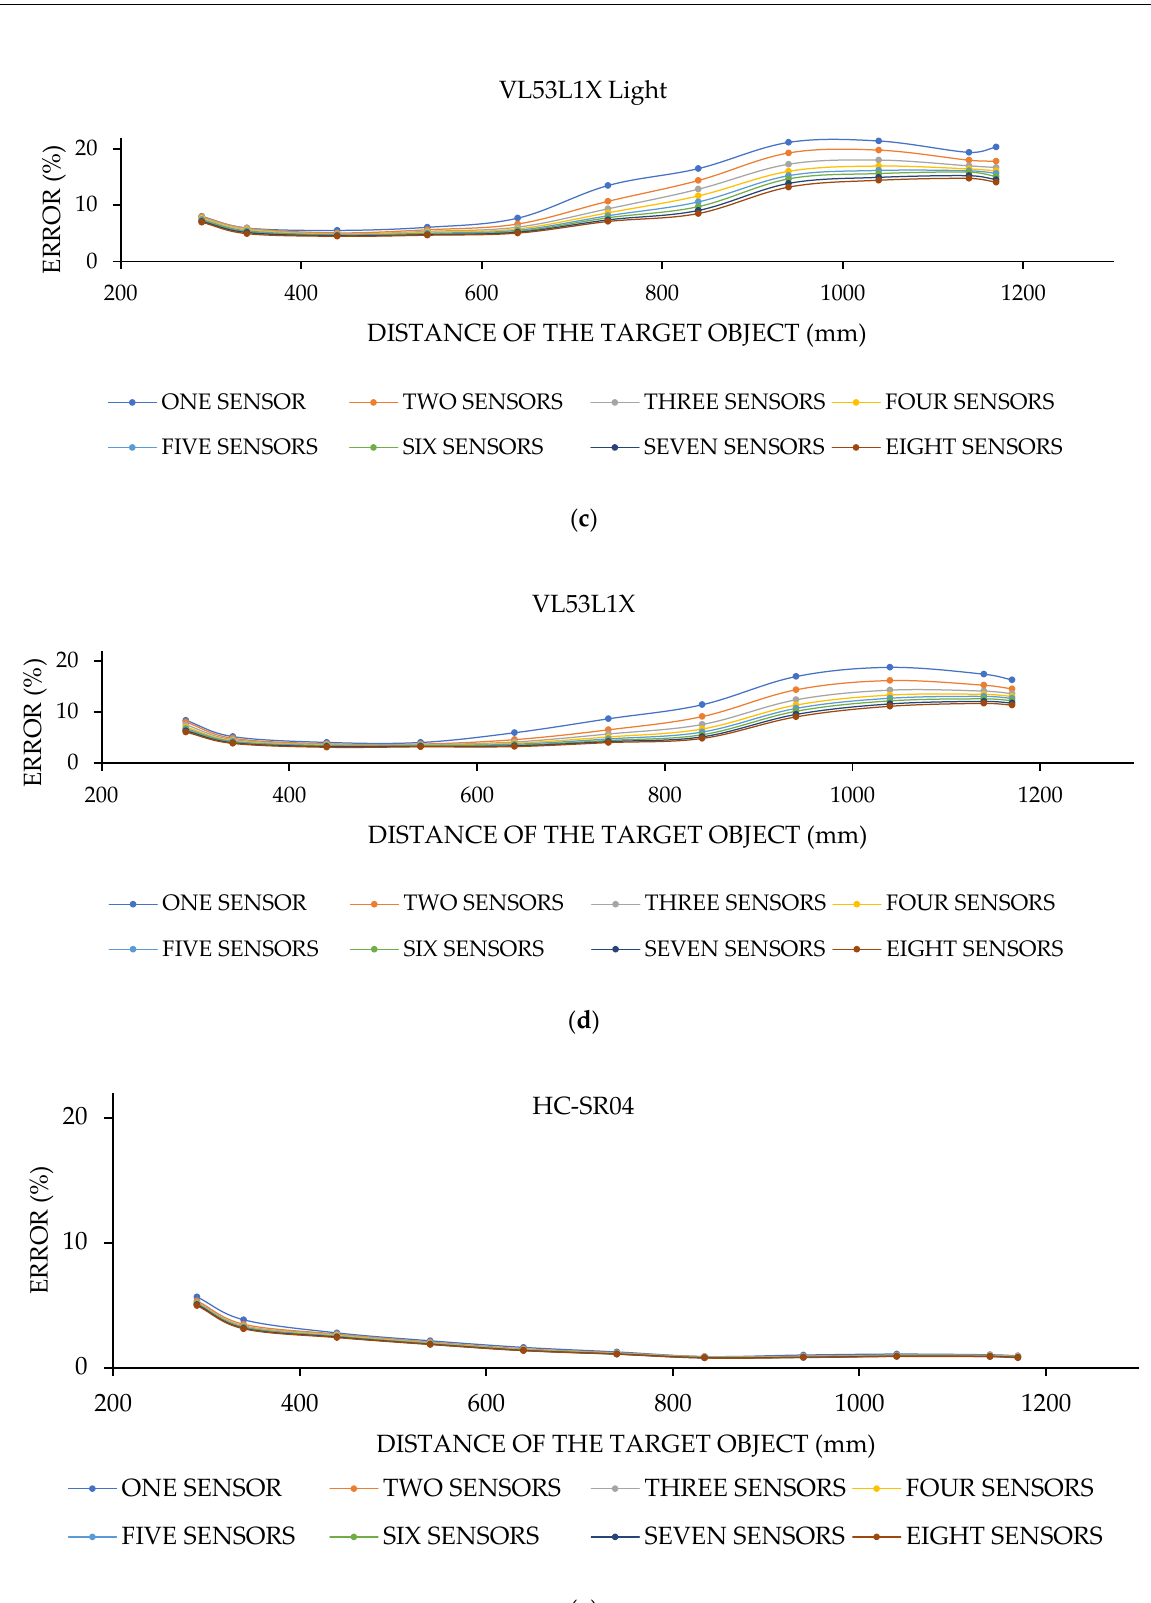
Figure 11. Comparing the worst-case sensor combination with different distance measurement technologies: ( a ) VL53L0X distance estimations affected by an excessive light source, ( b ) VL53L0X distance estimations in darkness, ( c ) VL53L1X distance estimations affected by an excessive light source, ( d ) VL53L1X distance estimations in darkness, and ( e ) HC-SR04 distance measurements.